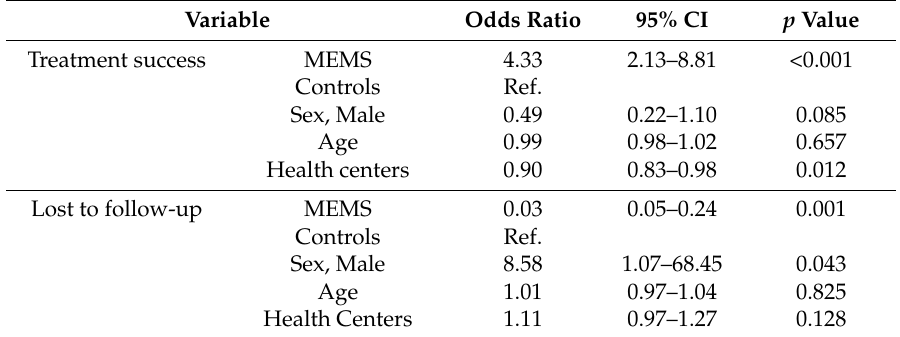
Table 2. Logistic regression model assessing independent predictors of treatment success and lost to follow-up for the case holding strategy for tuberculosis (TB) treatment.